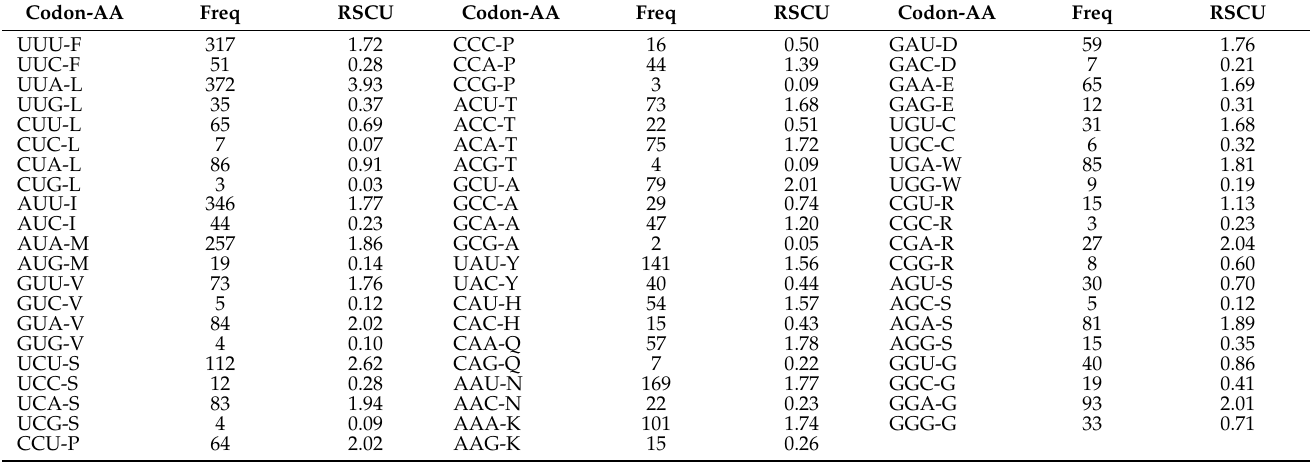
Table 4. Codon usage in the mitochondrial genome of the Olive Seed Weevil, Anchonocranus oleae . Amino acids are labelled according to the IUPAC-IUB single letter codes. N—total number of occurrences in all protein-coding genes, RSCU—relative synonymous codon usage.